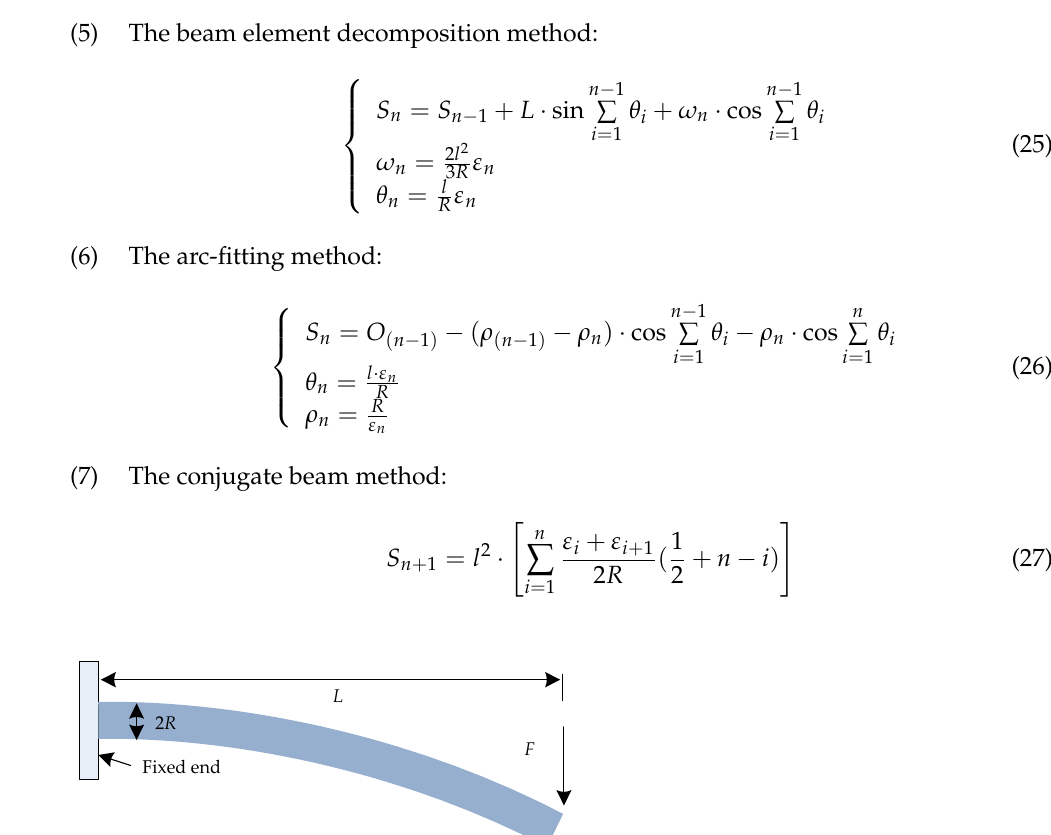
Figure 11. Relationship between radius of groove and average strain-transfer coefficient.